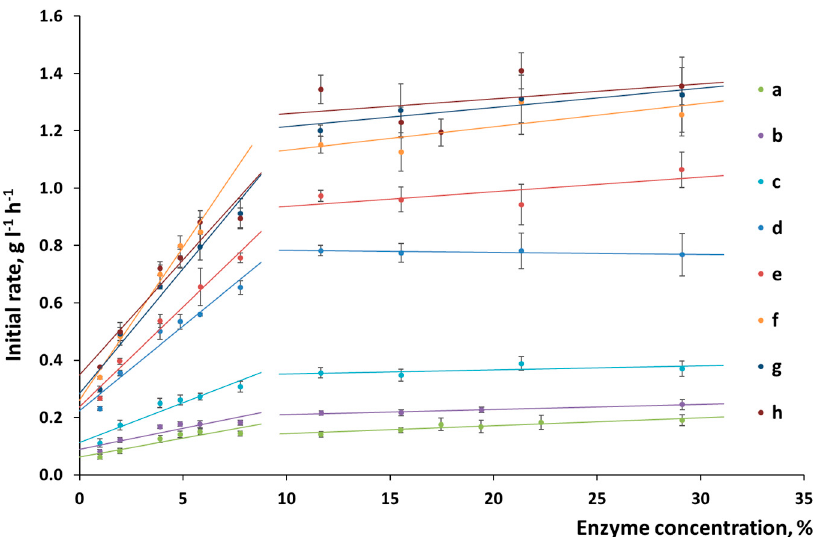
Figure 5. The initial rate of hydrolysis of wheat straw as a function of enzyme concentration: ( a ) without mechanical activation and after mechanical activation for ( b ) 2 min; ( c ) 5 min; ( d ) 10 min; ( e ) 15 min; ( f ) 20 min; ( g ) 25 min; and ( h ) 30